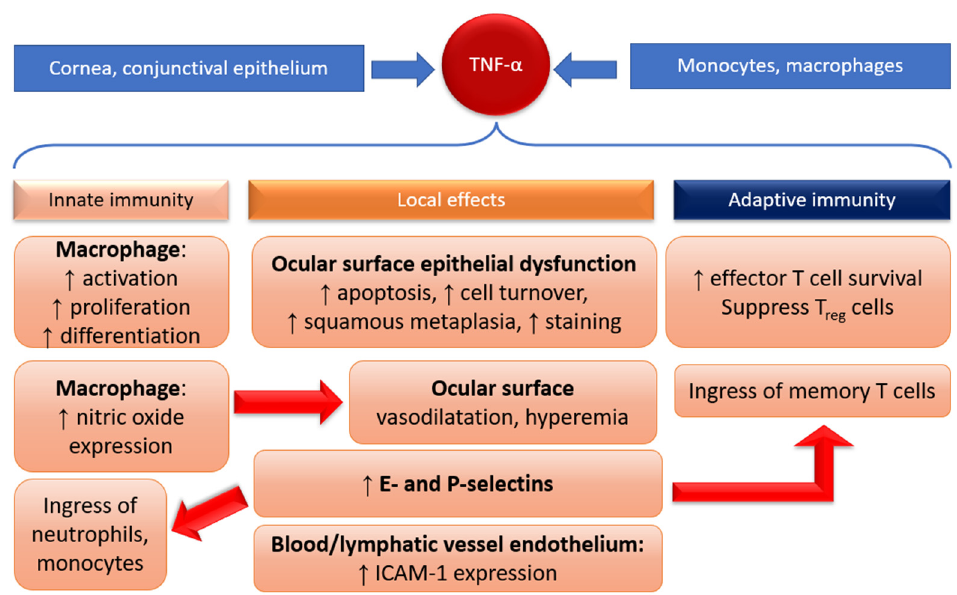
Figure 1. Many roles of TNF- α in potentiating DED inflammation ( ICAM = intracellular adhesion molecule). sio molecule